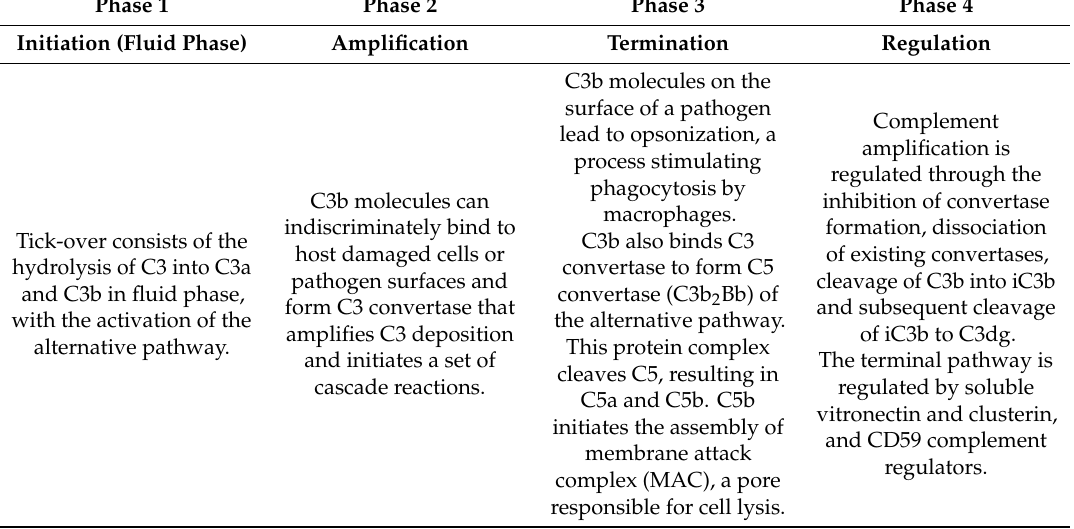
Table 2. Phases of the alternative complement pathway, adapted by Zewde et al. [141]. Phase 1 Phase 2 Phase